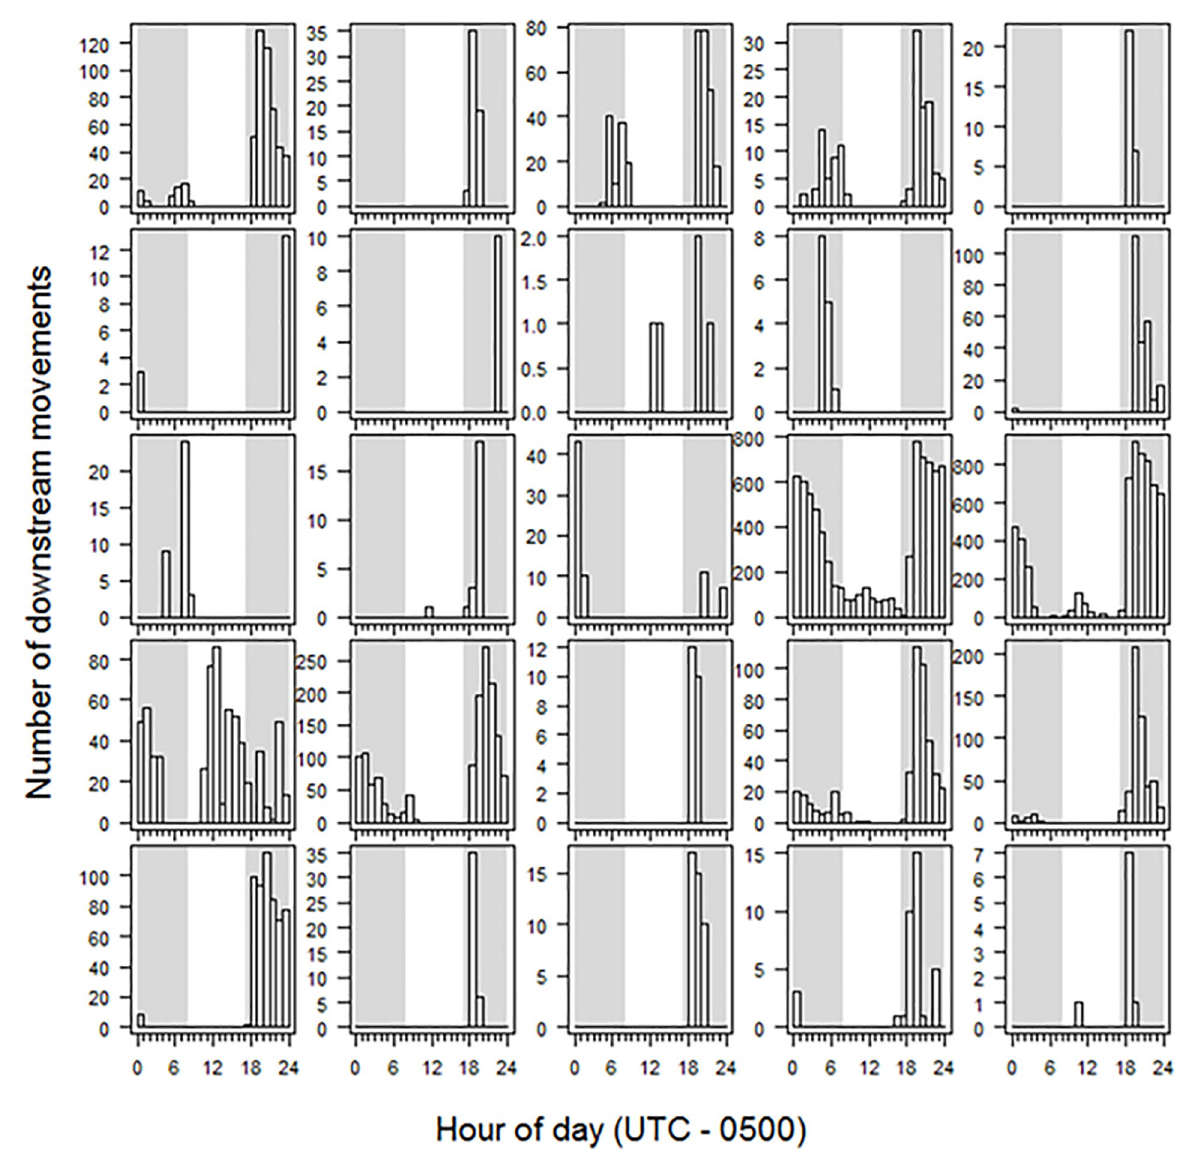
Fig 7. Study III: Individual downstream movement activity for juvenile sea lamprey in an artificial stream. Number of downstream movements (vertical bars) detected during each hour of the day for each of 25 tagged juvenile sea lamprey (one per plot) in an artificial stream November 6, 2014 –February, 2, 2015. Shading indicates nominal day/night hours (delineated by median sunrise and sunset).